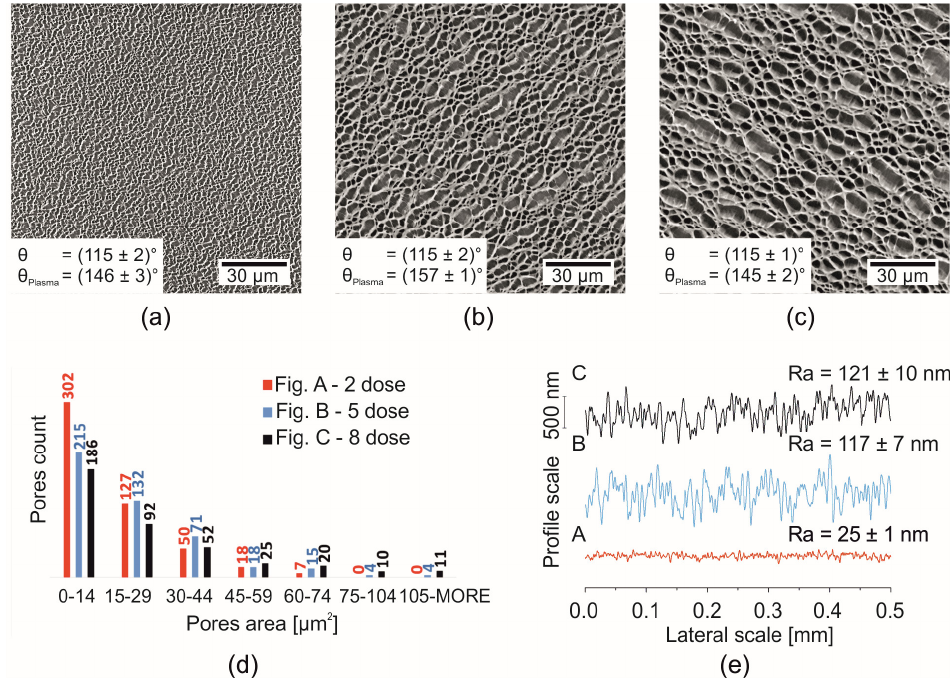
Figure 6. The effect of PS surface microtopography on the water contact angle values after plasma modification. The smooth borders of the microtextured surfaces were prepared from ( a ) two, ( b ) five, and ( c ) eight doses used in the time-sequenced phase separation process [23]. Pore size distribution ( d ), and surface profiles ( e ). SEM micrographs ( a – c ). The smooth borders were prepared with two, five, or eight doses of 1.5 THF:8.5 ETH at 295 K. The power of the plasma reactor was 300 W.